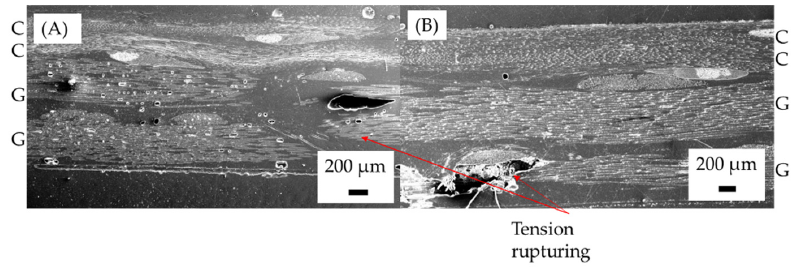
Figure 18. Hybrid fibre reinforced plastic cycled at 70% maximum flexural loading under SEM im ‐ aging to image glass fibres for HF after ( A ) 4000 cycles and HFT after (B) 4000 For HF, there was extensive glass fibre failure, with inter ‐ ply carbon failure on the bottom layer. The carbon fibre layer in HFT, however, was shown to fail by kink banding with extensive delamination between the carbon–carbon and carbon–glass layers. Figure 19 shows an important failure mechanism with the veil, where the veil maintains structure without breaking during matrix cracking, thus reducing the area of failure. After 100,000 cycles, kink banding occurred in the second carbon fibre layer due to inter ‐ ply delamina ‐ tion from the first carbon fibre layer failure. After 100,000 cycles, the glass fibre began to fail, leading to further reduction in flexural modulus as fibre cracking occurred and re ‐ sulting in the carbon fibre layer ply cracking. The ply cracking was not observed in HFT, which maintained the higher modulus after 100,000 cycles.